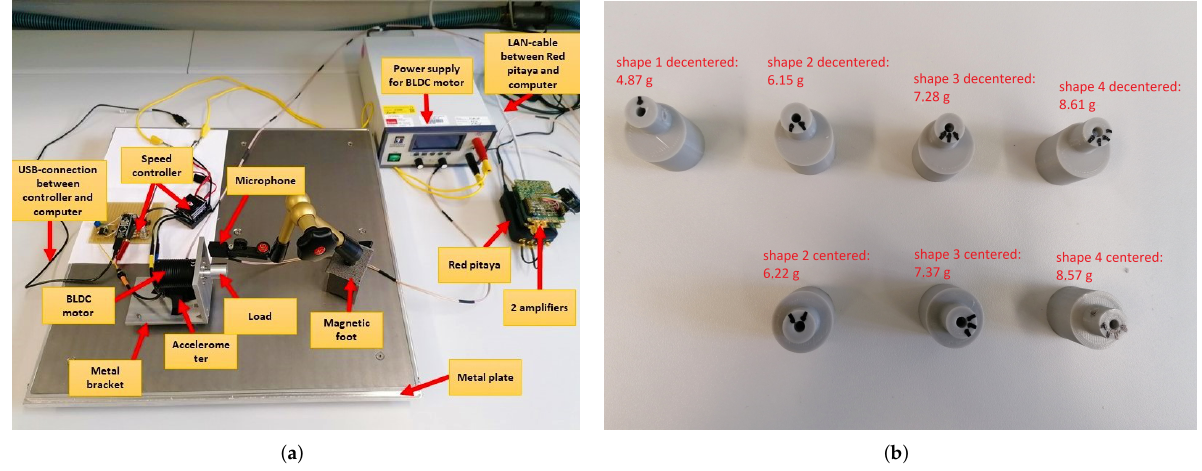
Figure 2. Experimental setup. ( a ) Setup. ( b ) Loads mounted on the